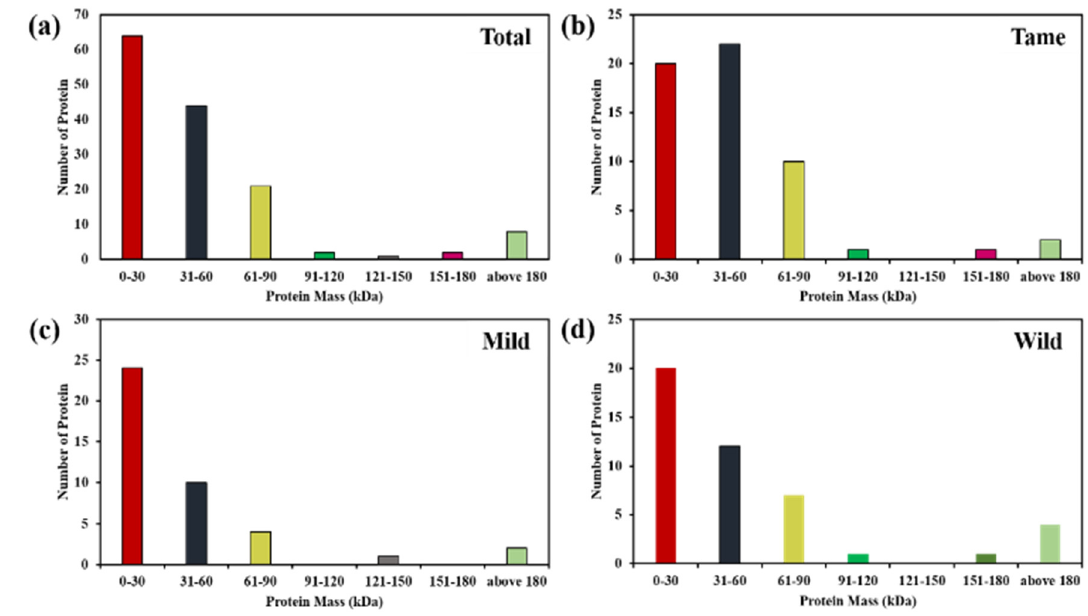
Figure 7. Comparative analysis of identified total protein CWY ( a ) Tame Protein CW ( b ), Mild Protein CY ( c ) and Wild Protein WY ( d ) on the basis of molecular masses.